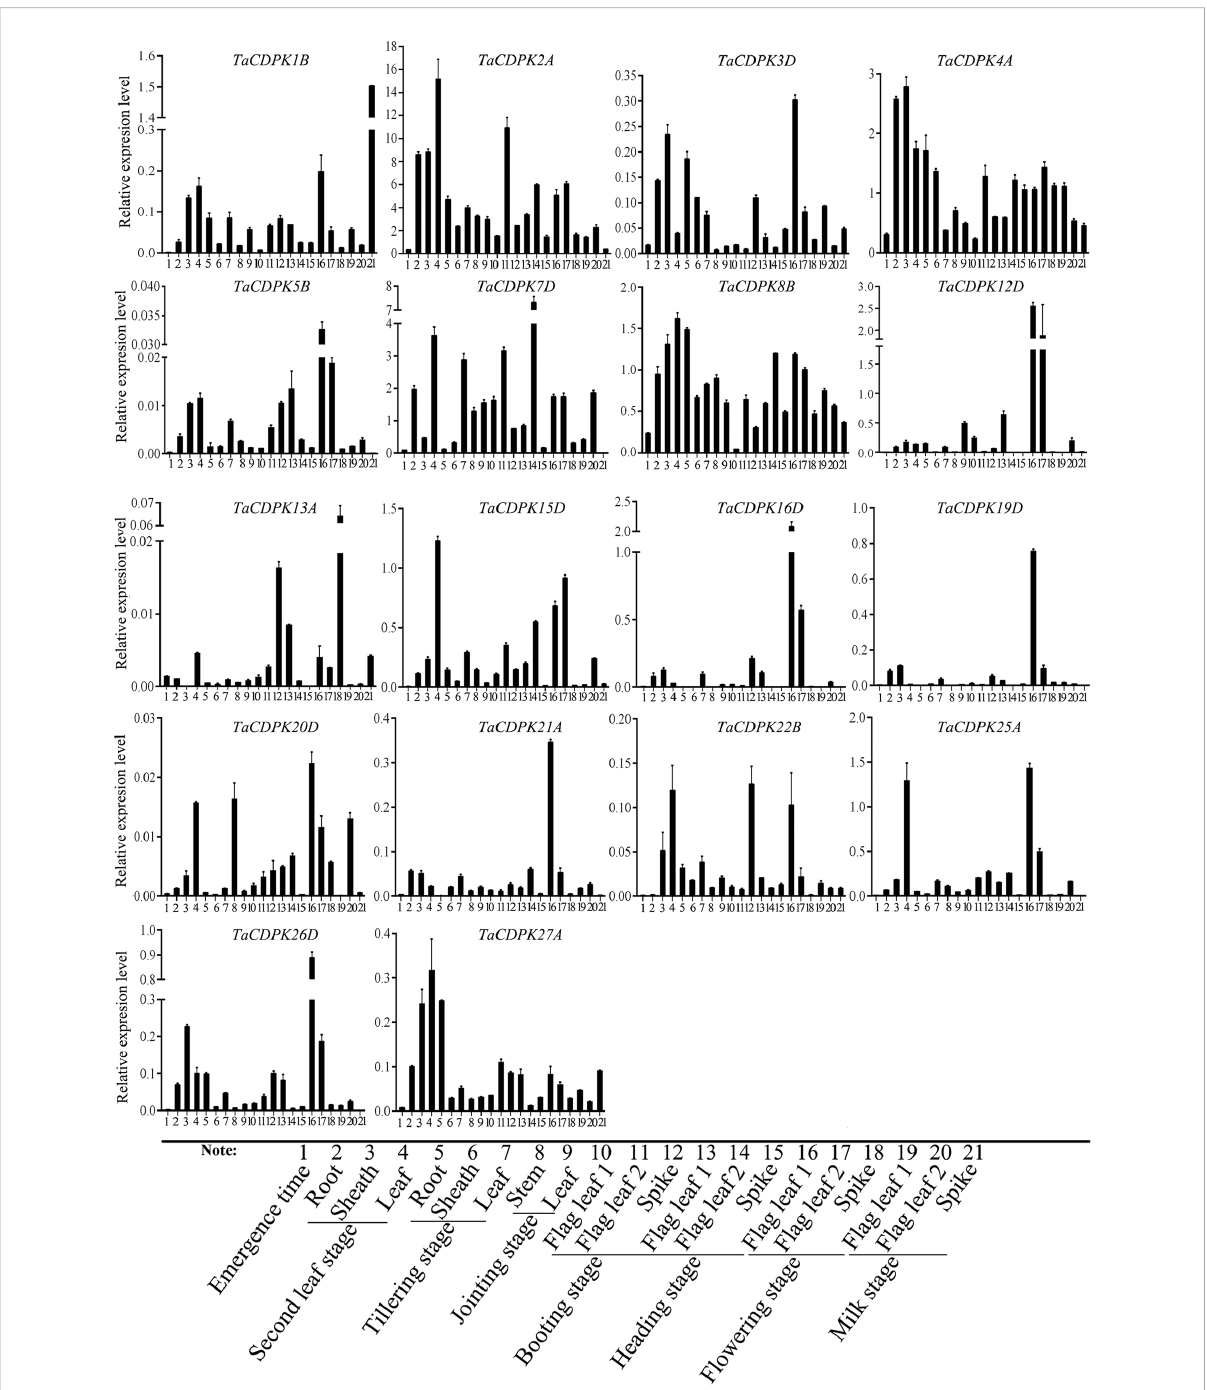
FIGURE 4 The tissue-speci fi c and spatio-temporal expression pro fi les of TaCDPKs in wheat by qRT-PCR. Expression analysis of TaCDPKs in 21 tissues from 8 different development stages of wheat by qRT-PCR. All the expression levels represent the mean ± SD of data collected from the experiments with each having three or four